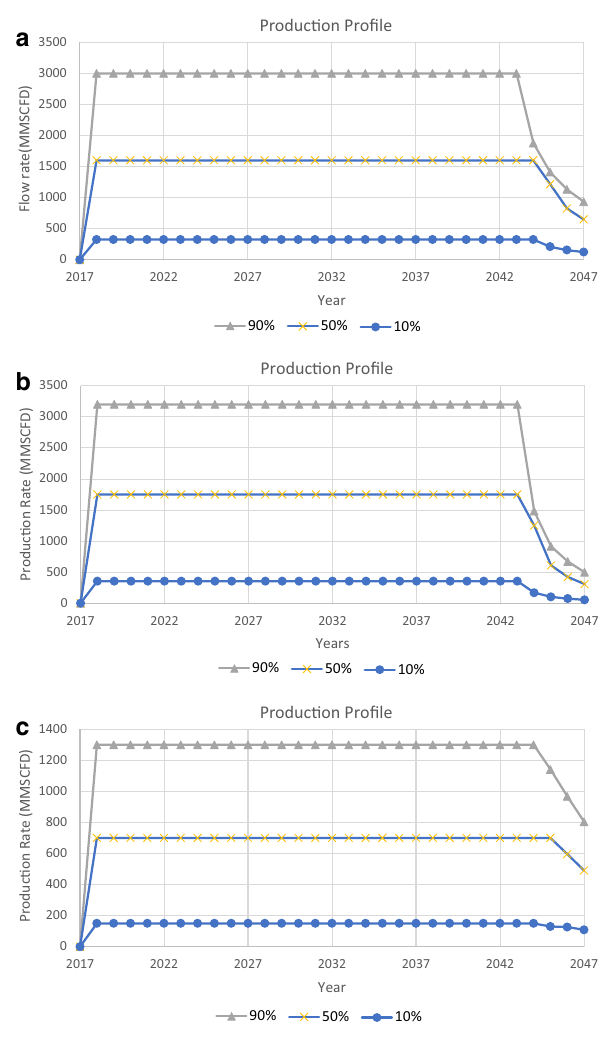
Fig. 6 a Production profile forecast for 300-ft well spacing. b Produc- tion profile forecast for 500-ft well spacing. c Production profile fore- cast for 700-ft well